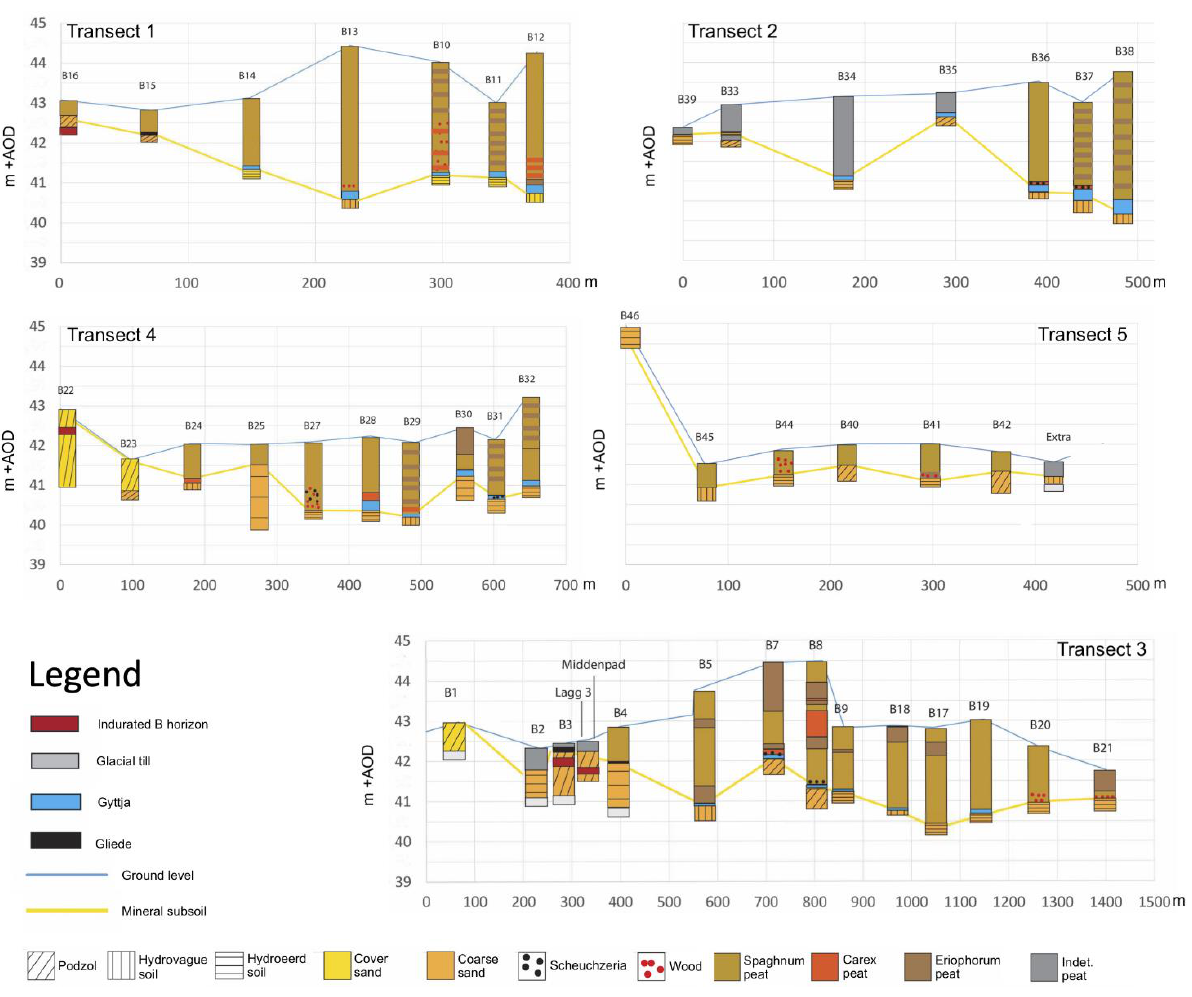
Figure 4. Transects with materials and soil types encountered. After Sevink & Jansen